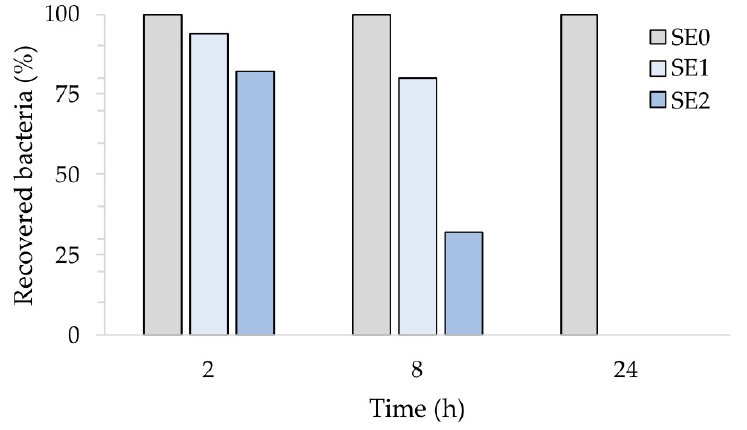
Figure 8. Antibacterial activity of the test surfaces against S. aureus after 2, 8 and 24 h of exposure.